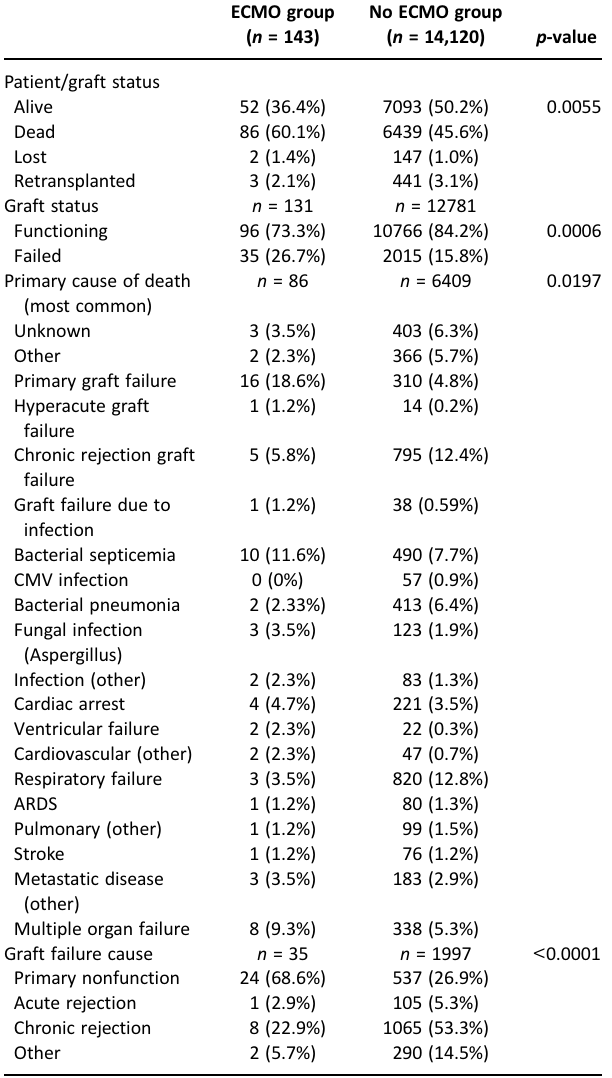
Table 7. Recipient graft status.